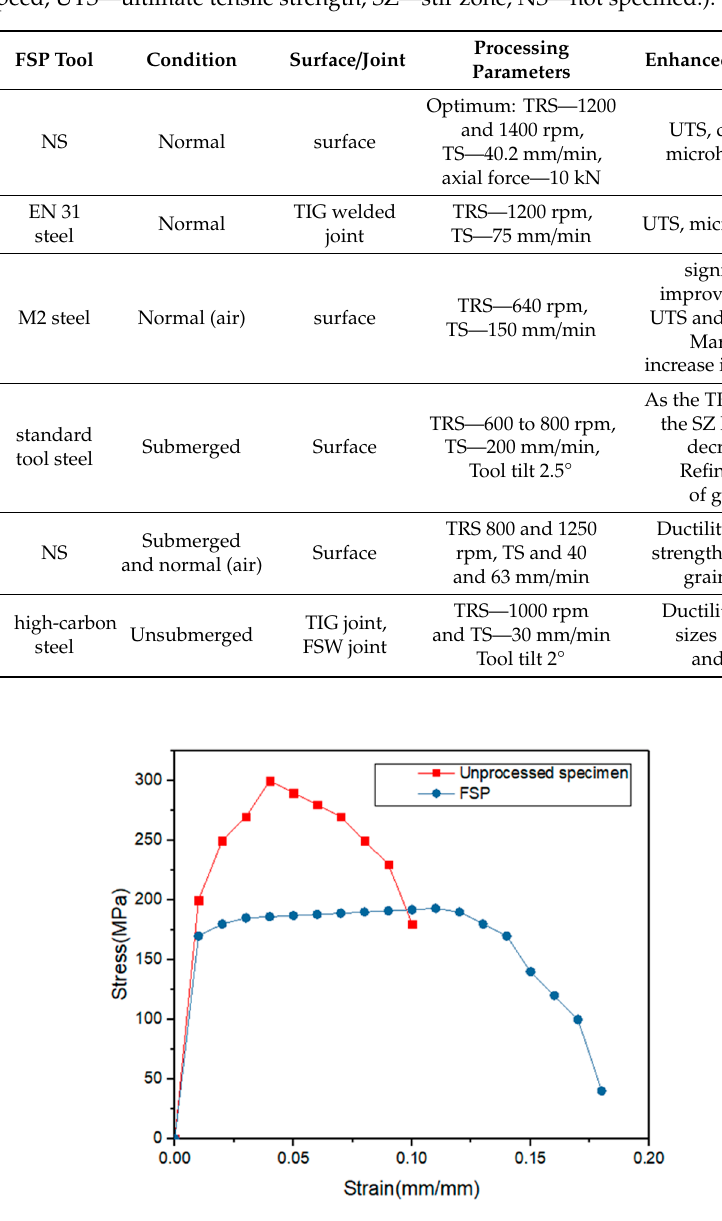
Table 3. Typical results of friction stir processed plate and joints. (TS—traverse speed, RTS—tool